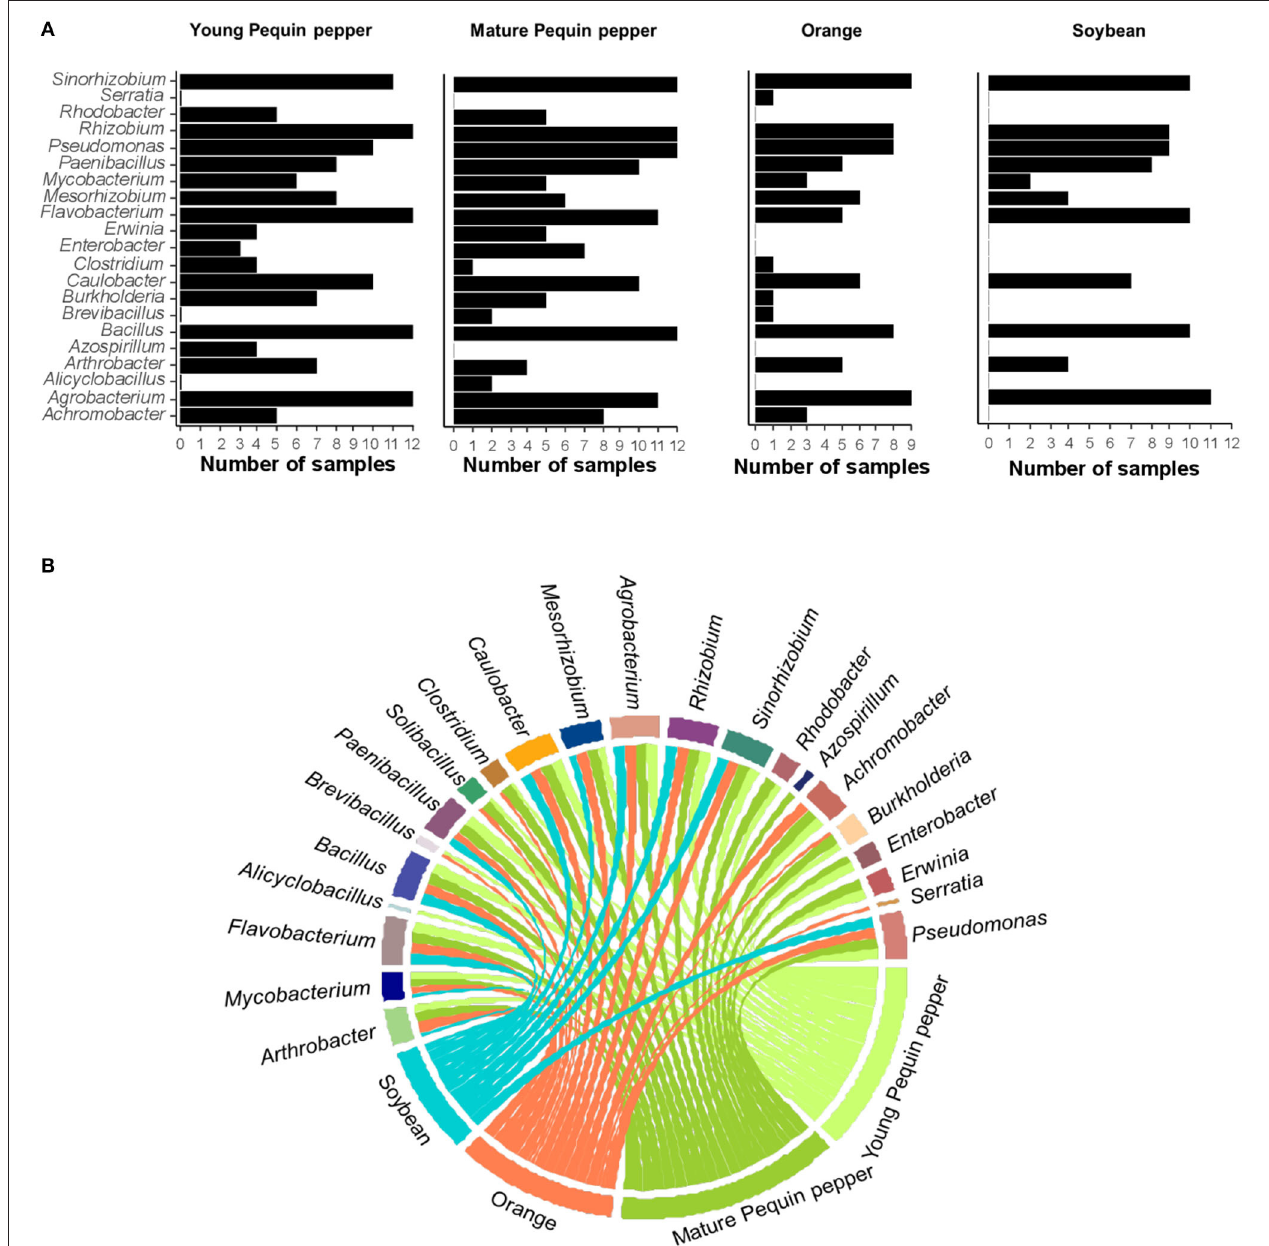
FIGURE 7 | Presence of plant growth promoting rhizobacteria (PGPR) genera in crops during experimental period (four samples per sampling time, except for orange with three samples). (A) Bar plot of presence/absence of PGPR genera per cumulative number of samples. (B) Circus plot of PGPR genera where thickness of line represents the number of samples each genus was present in each